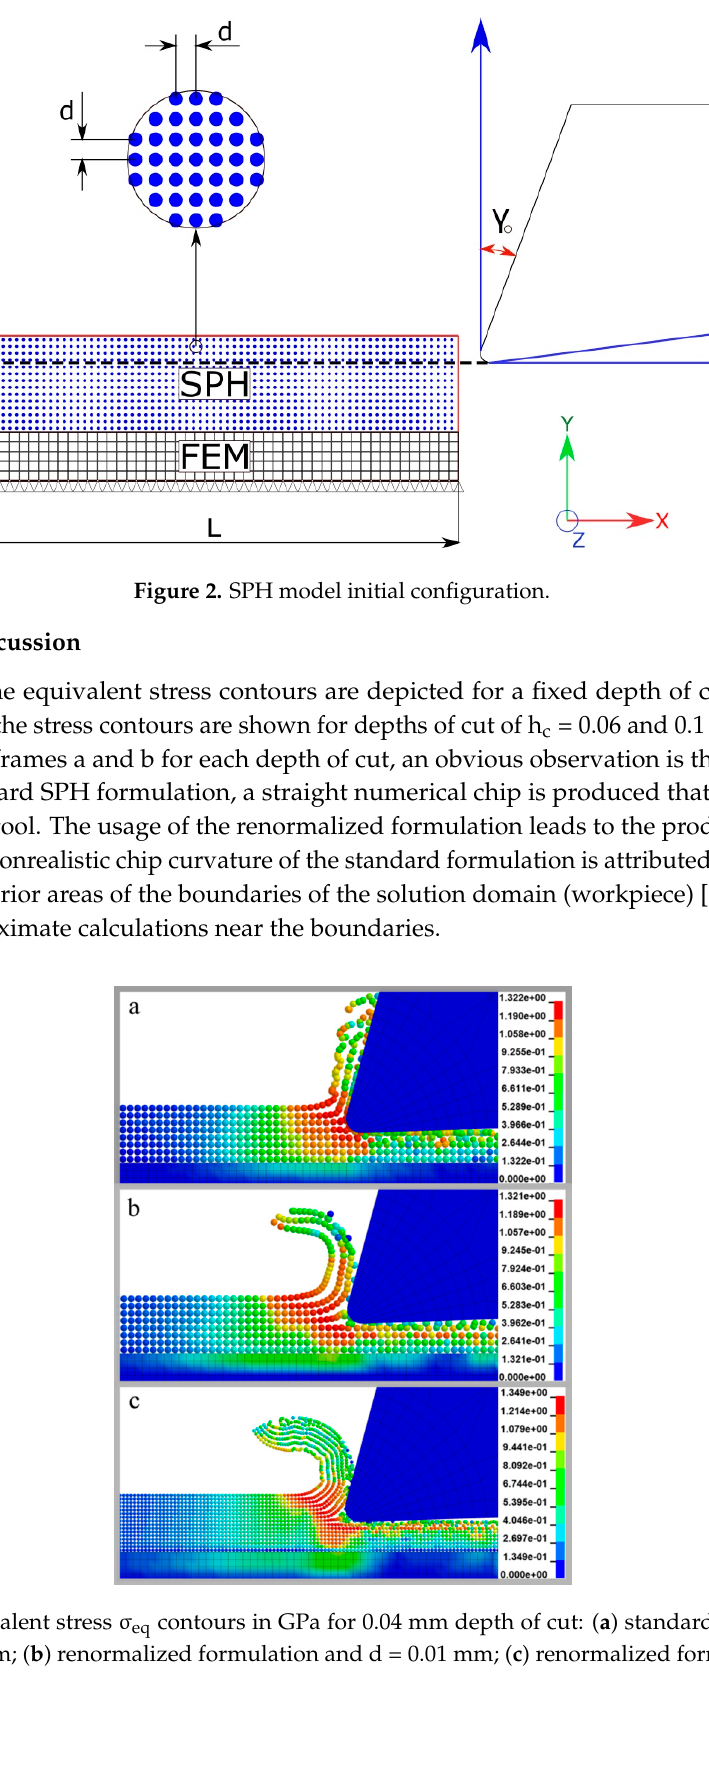
Figure 4. Equivalent stress σ eq contours in GPa for 0.06 mm depth of cut: ( a ) standard formulation and d = 0.01 mm; ( b ) renormalized formulation and d = 0.01 mm; ( c ) renormalized formulation and d = 0.005 mm.